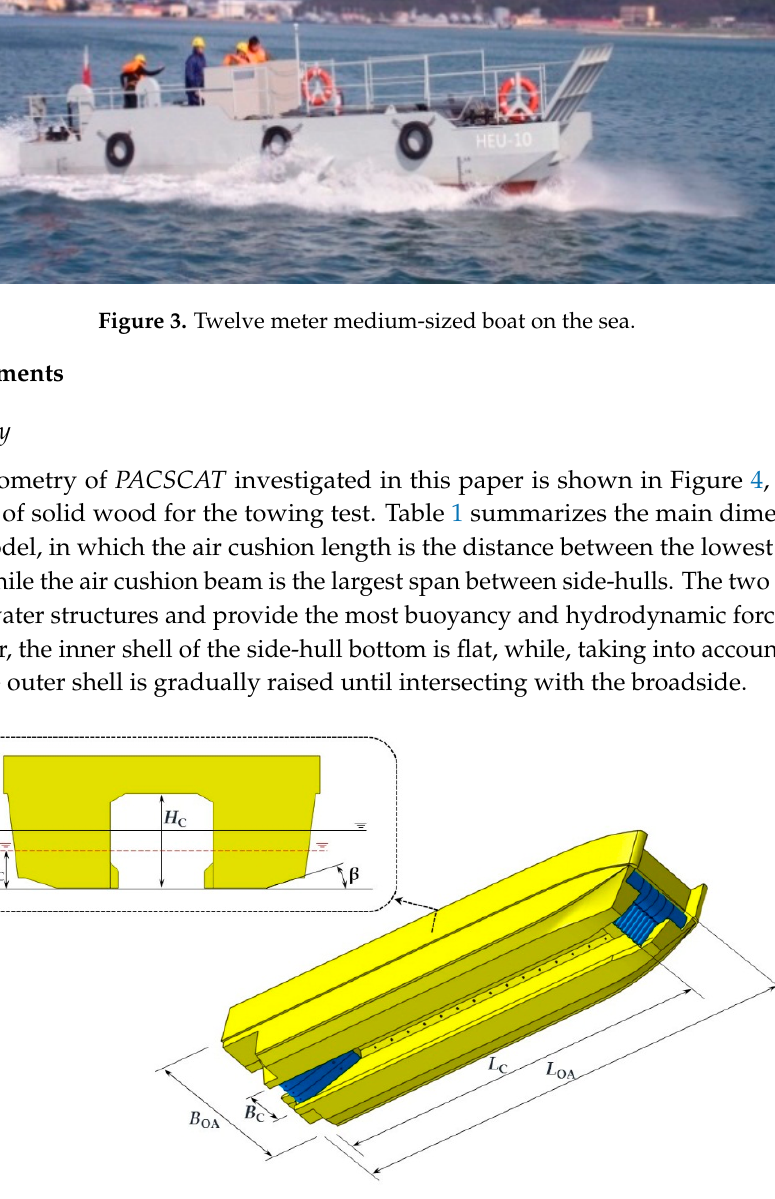
Figure 4. Hull geometry of PACSCAT .